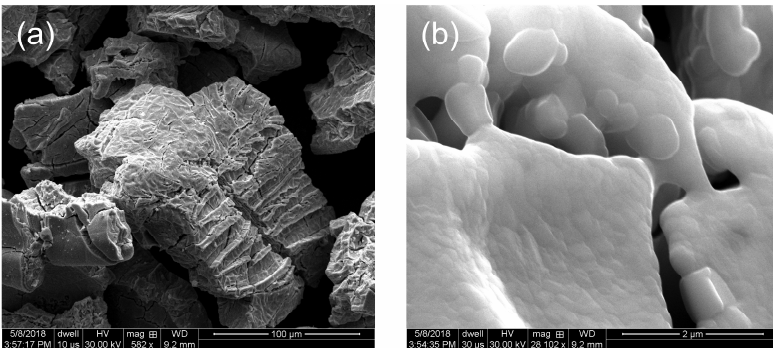
Figure 10. SEM images of the product from thermolysis of 1 at 1100 °C under an atmosphere of 10% H 2 (Ar balance). Scale bar: ( a ) 100 µ m and ( b ) 2 µ m.